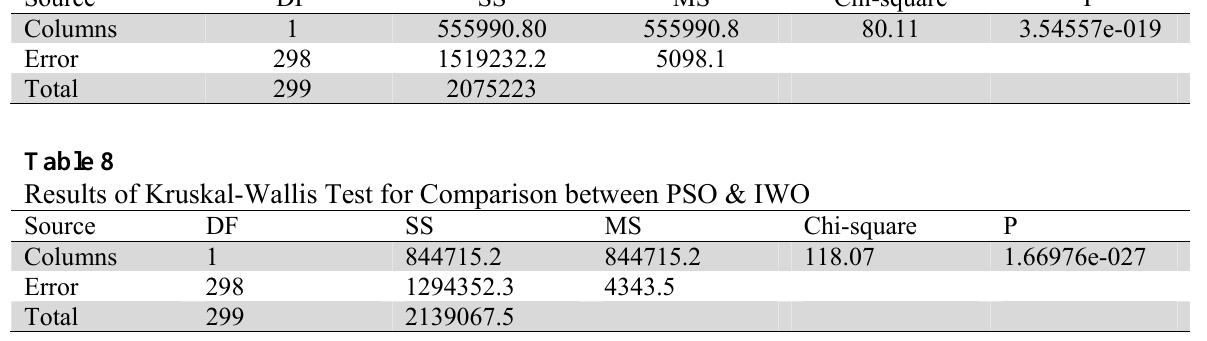
Results of Kruskal-Wallis Test for Comparison between GA & IWO Source